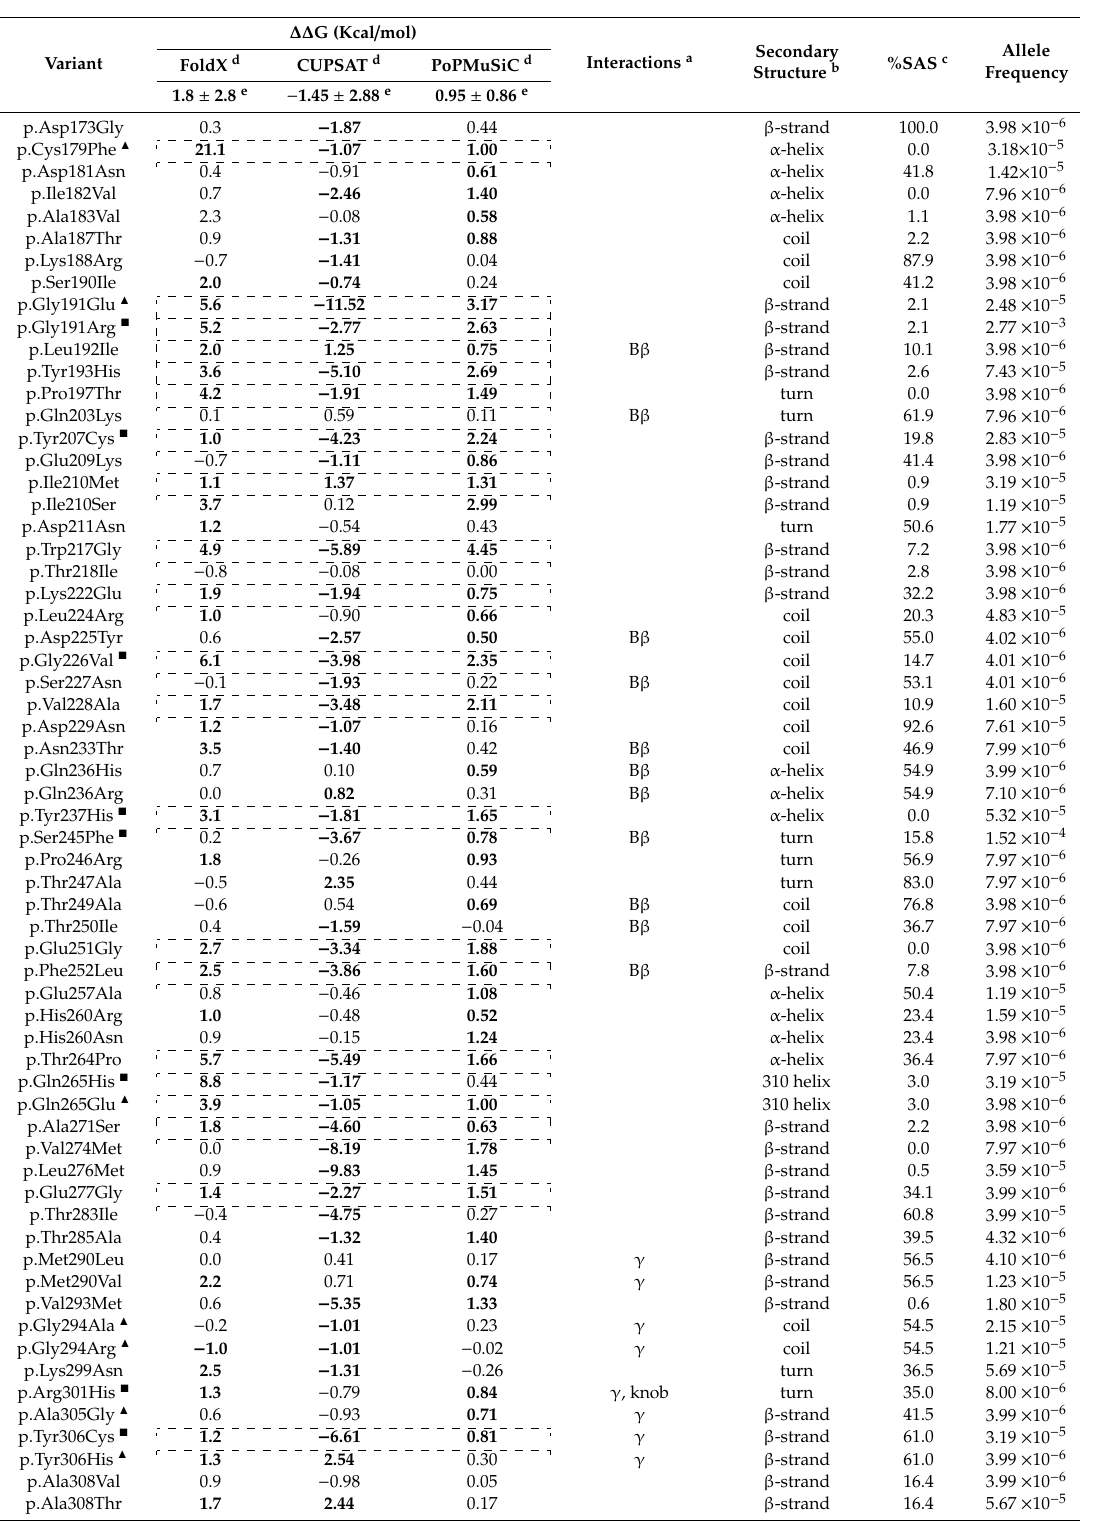
Table 2. ∆∆ G values of γ -module gnomAD missense